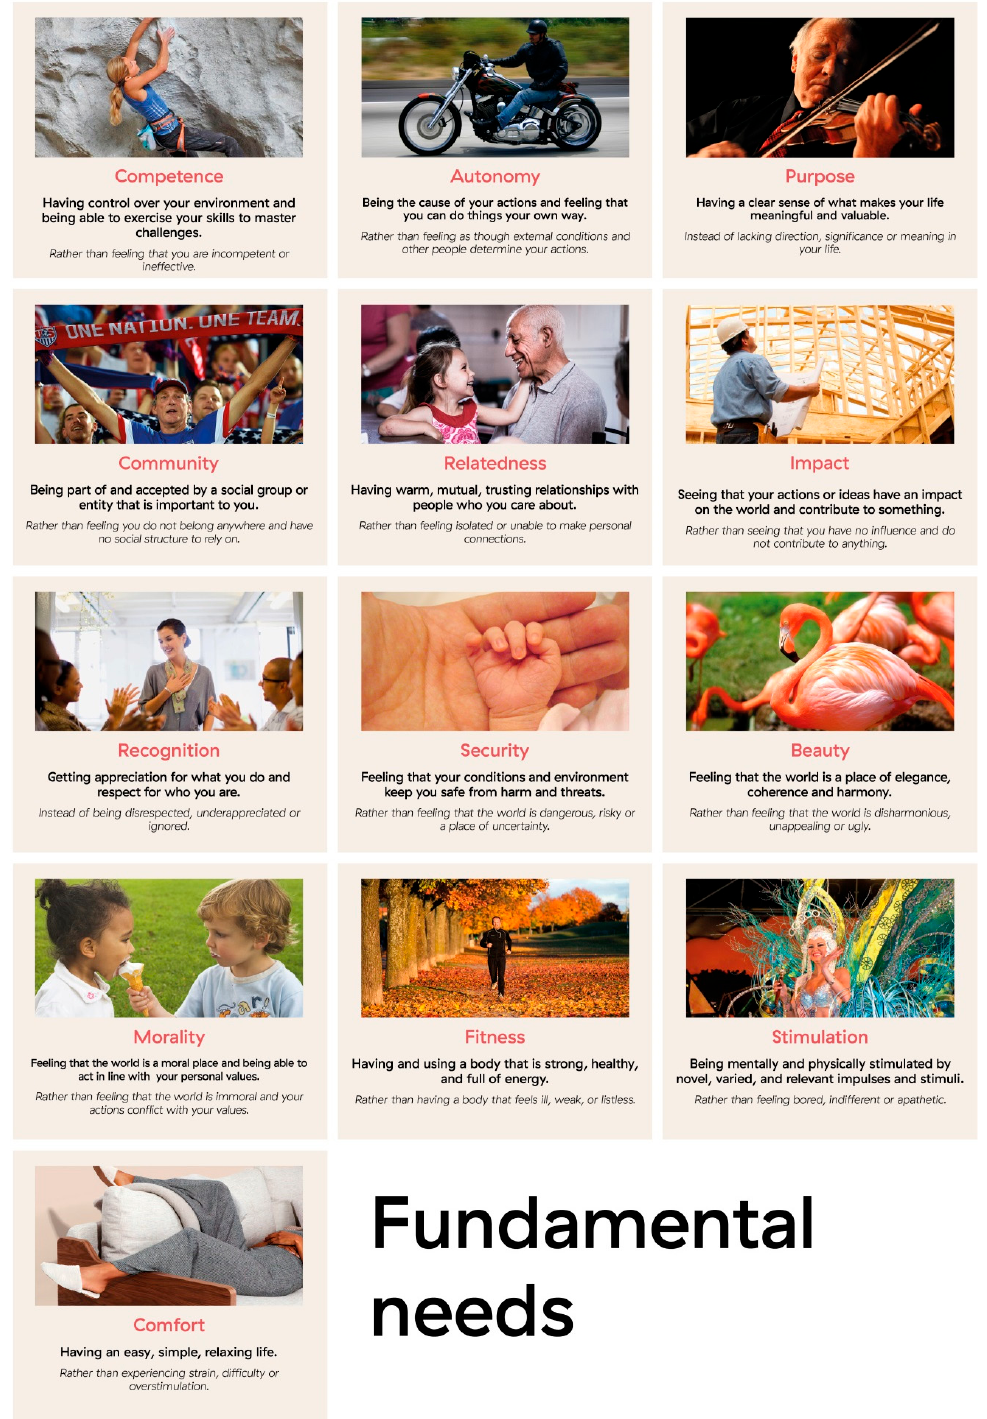
Figure 4. Illustrated overview of the fundamental needs typology